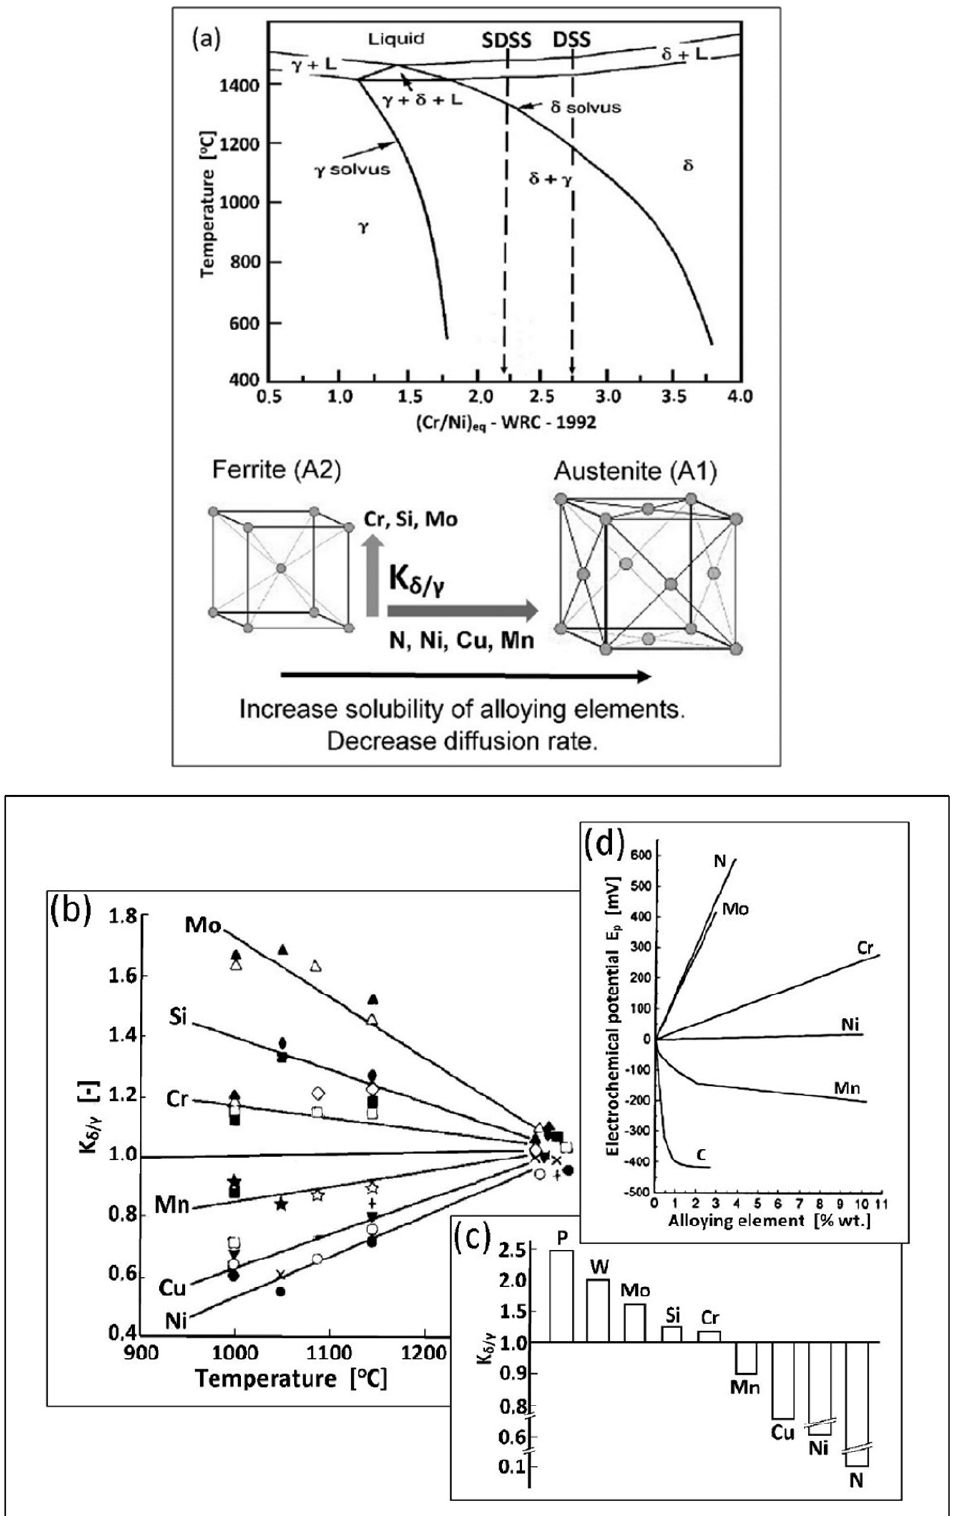
Figure 5. Metallurgical transformations in duplex steels: ( a ) phase equilibrium diagram and austenitic transformation δ → δ + γ (according to [27]), ( b ) distribution coefficient of alloy additions K δ / γ as a function of temperature (according to [28]), ( c ) typical values of the partition coefficient of alloying elements K δ / γ for supersaturated and water-cooled steels (according to [28]), ( d ) influence of alloying elements on the size of electrochemical austenite potential in stainless steels 18/8 (according to